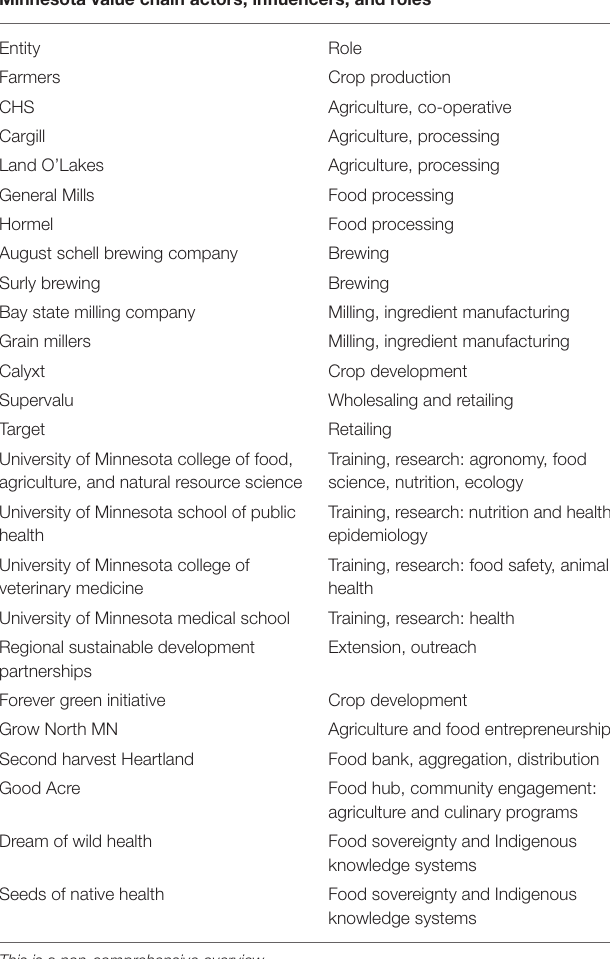
TABLE 1 | Recommendation of value chain actors, influencers, and roles in Minnesota. Minnesota value chain actors, influencers, and